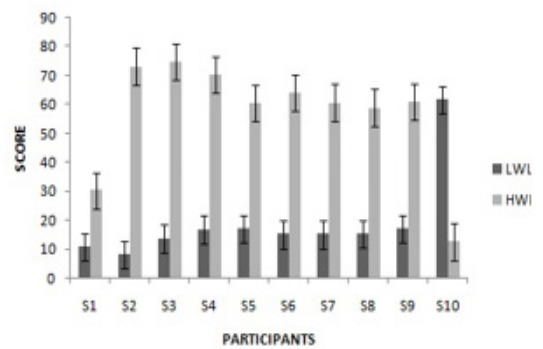
Figure 2. Total NASA-Tlx score of participants in the MATB-II